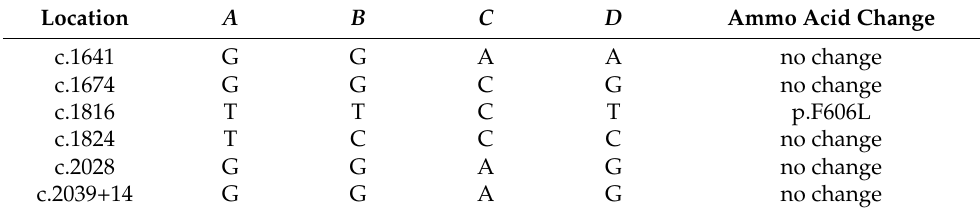
Table 3. Genotype frequencies of EPAS1 exon15 in sheep.